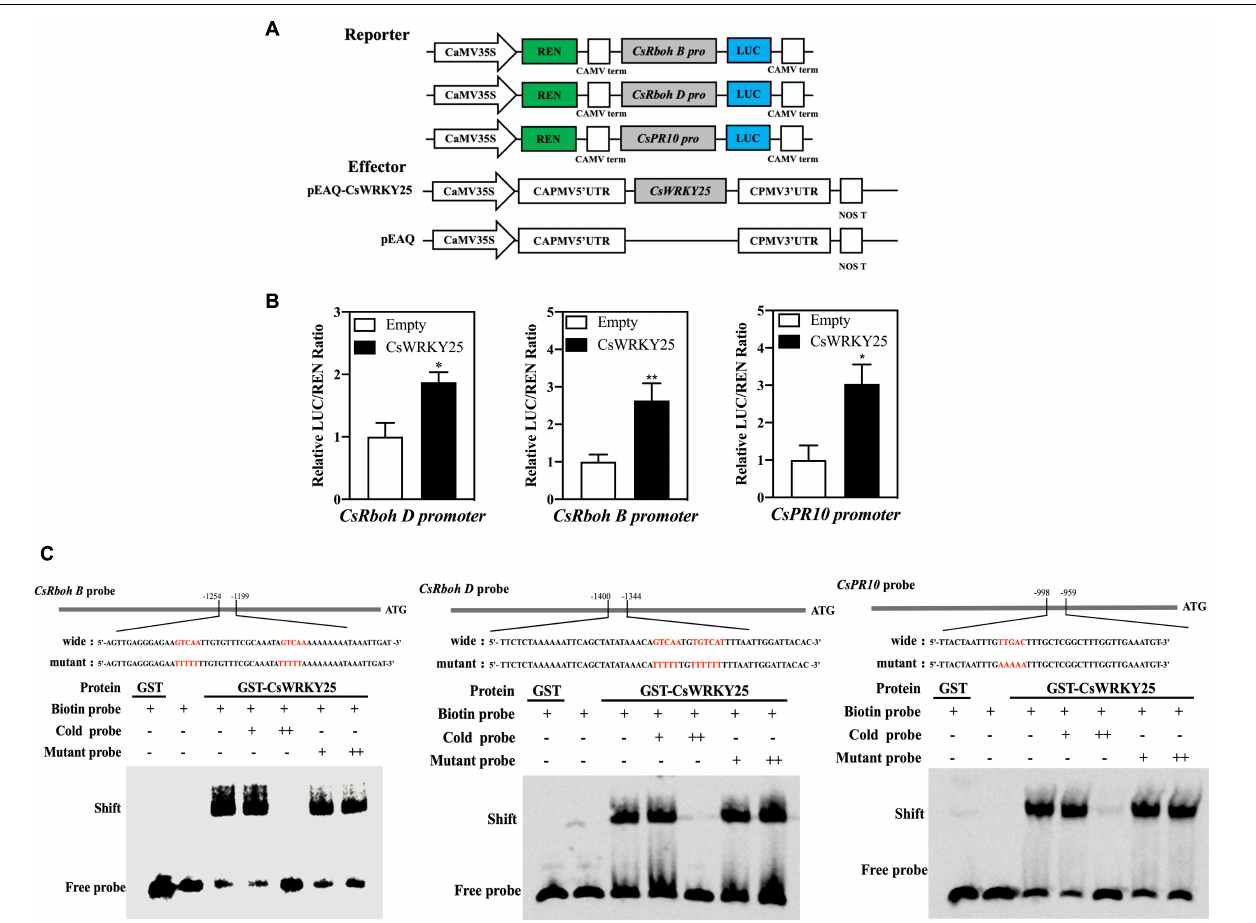
FIGURE 3 | The effects of CsWRKY25 on the transcriptions of CsRbohB , CsRbohD , and CsPR10 by binding to W-box. (A) Diagram of the vector construction used in the dual-luciferase transient expression assay. (B) The transcriptions of CsRbohB, CsRbohD, and CsPR10 were activated by CsWRKY25. Values equal the mean ± SE ( n = 6). (C) GST-CsWRKY25 binded to the CsRbohB , CsRbohD and CsPR10 promoters via the W-box element. Cold probe (unlabeled probe) is used as the competitor. “ − ”, “ + ” and “ + + ” represent absence, presence or 100-fold amounts of cold or mutant probe, respectively. The sequences of the wild-type or mutated probes are labeled with biotin, and W-boxes are shown using red letters. P values were regarded as statistically significant at * P < 0.05, ** P <